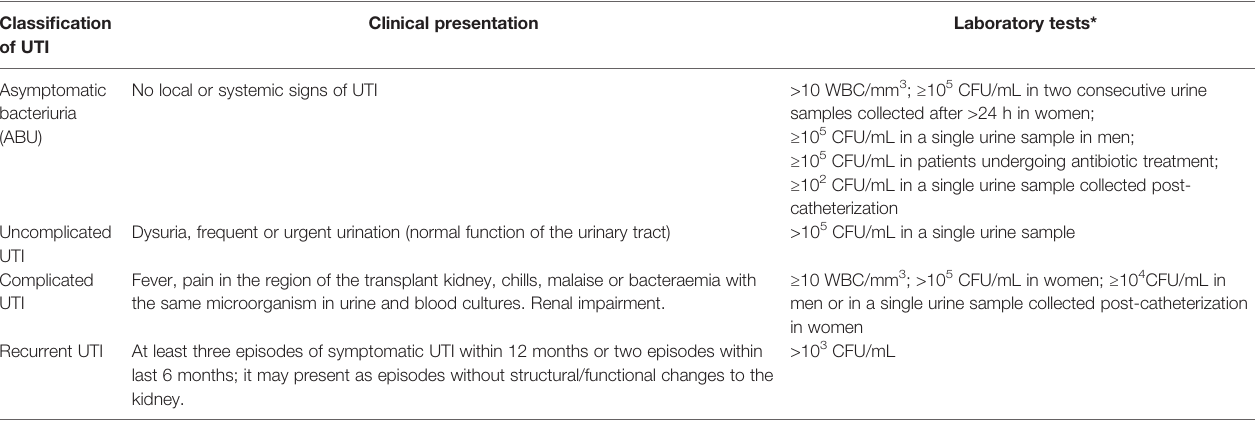
TABLE 1 | Diagnostic criteria of UTI in renal transplant recipients (Fishman and Issa, 2010; Parasuraman et al., 2013; Singh et. al., 2016a; Goldman and Julian,